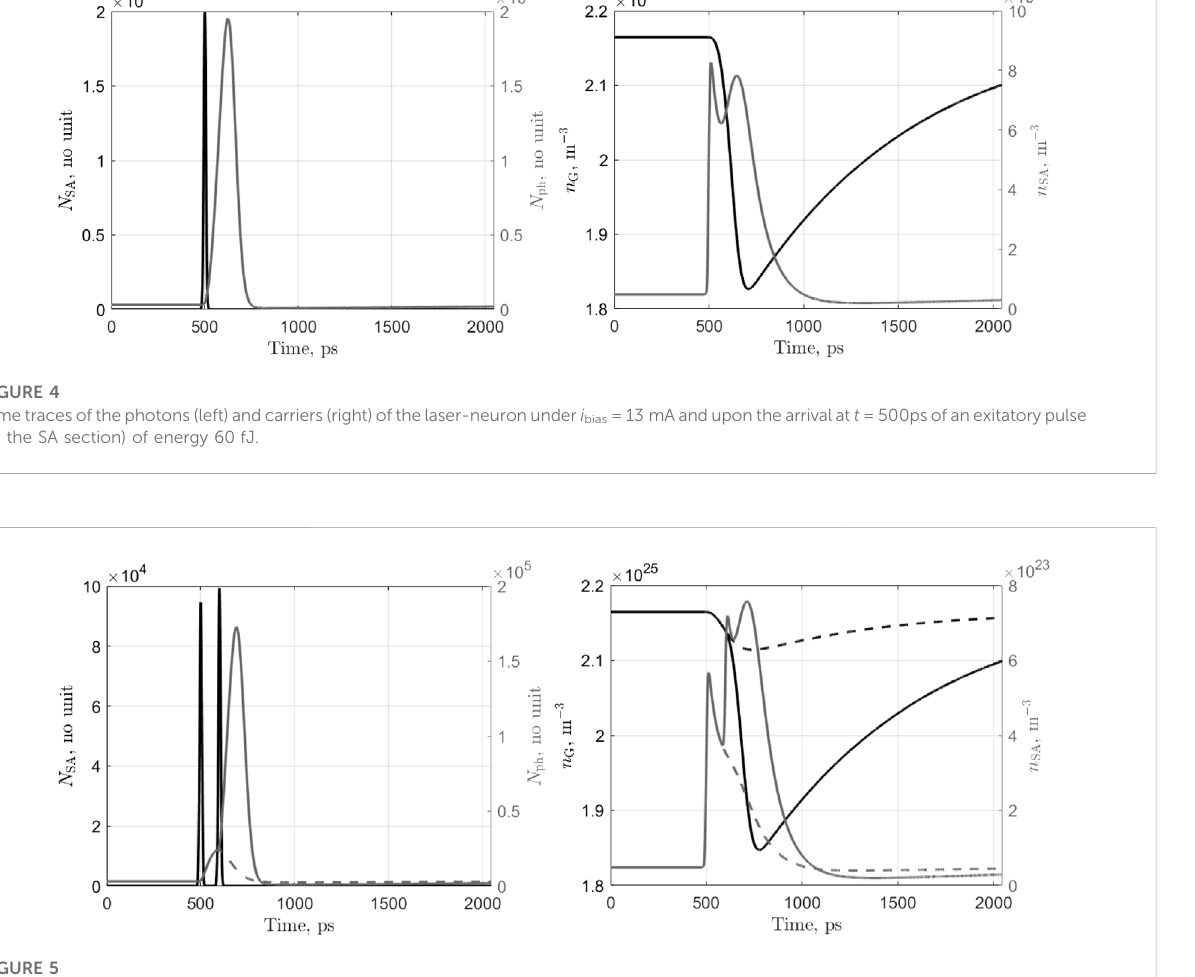
FIGURE 5 Time traces of the photons (left) and carriers (right) of the laser-neuron under i bias = 13 mA and upon the arrival at t = 500ps and 600ps of two exitatory pulses (in the SA section) each of energy 30 fJ. The dashed curves show the evolution of the parameters if only the fi rst pulse had been